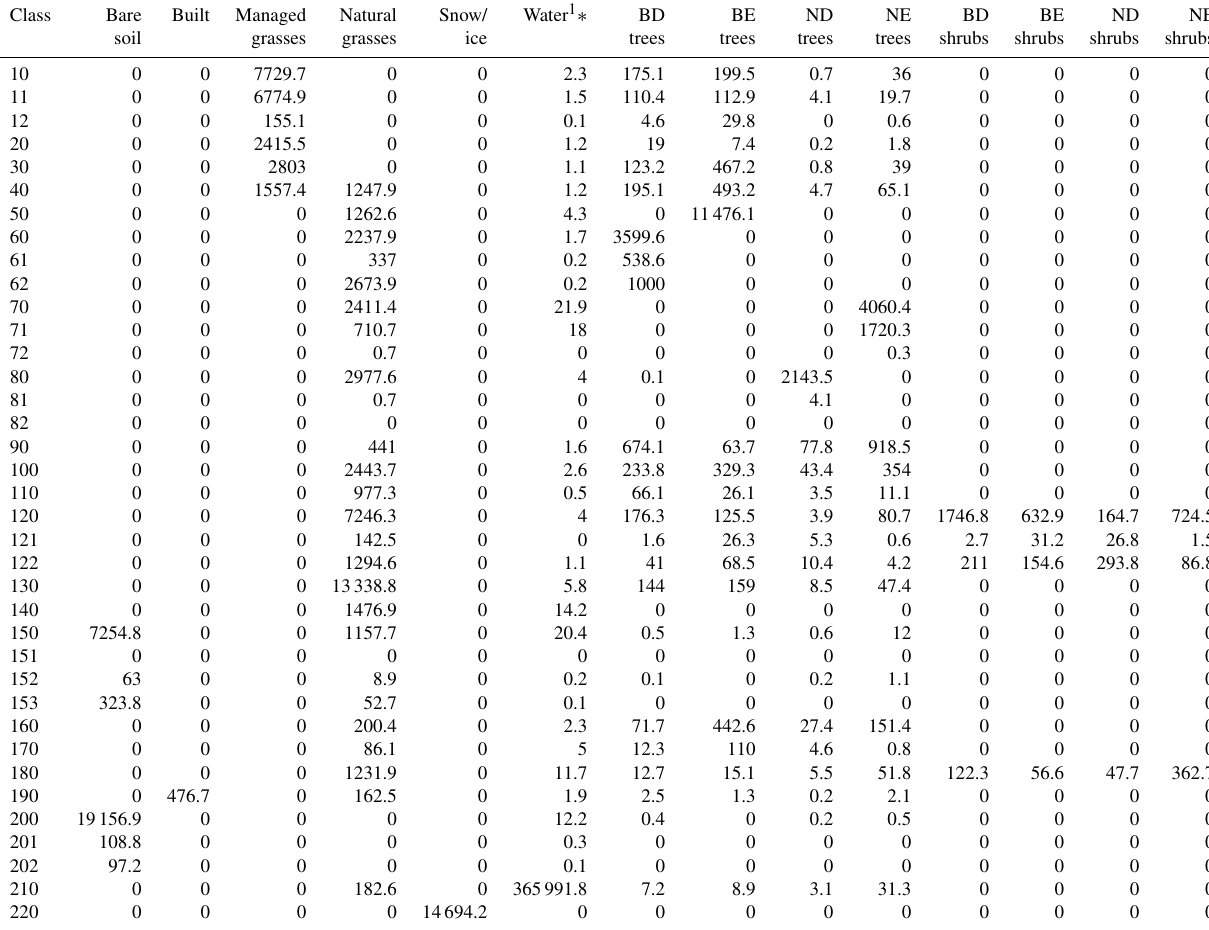
Table 3. Global areal cover (1000km 2 ) of each PFT by land cover class for 2010 in the PFT local product.